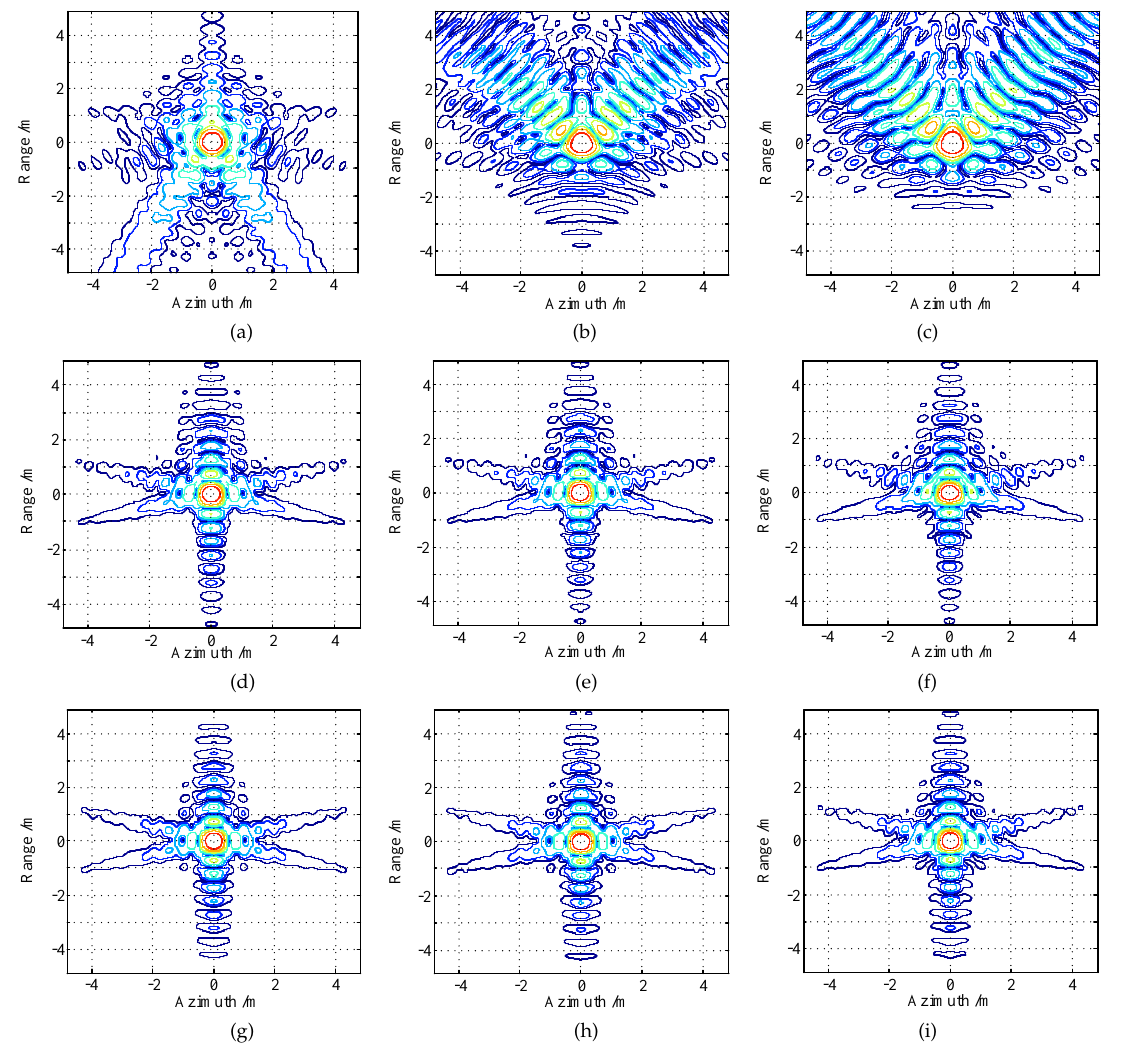
Figure 6. Focused results by different algorithm for P-band SAR data with a center frequency of 600 MHz. ( a – c ) Conventional generalized chirp scaling algorithm (GCSA). ( d – f ) Conventional GCSA with Lagrange inversion. ( g – i ) Proposed algorithm. The three subgraphs of each row correspond to contours of the targets located at R c , R c + 800 m and R c + 1600 m, respectively. The dynamic range of contour is − 35 dB ∼ 0